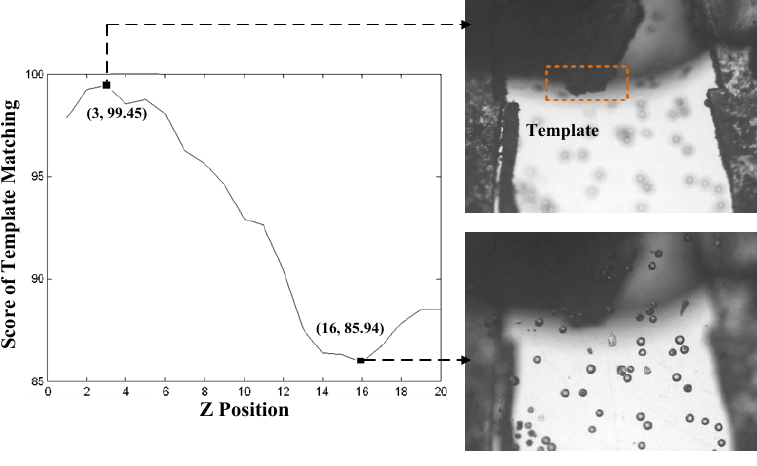
E in focusing gripper tips and particles. 2 PHF